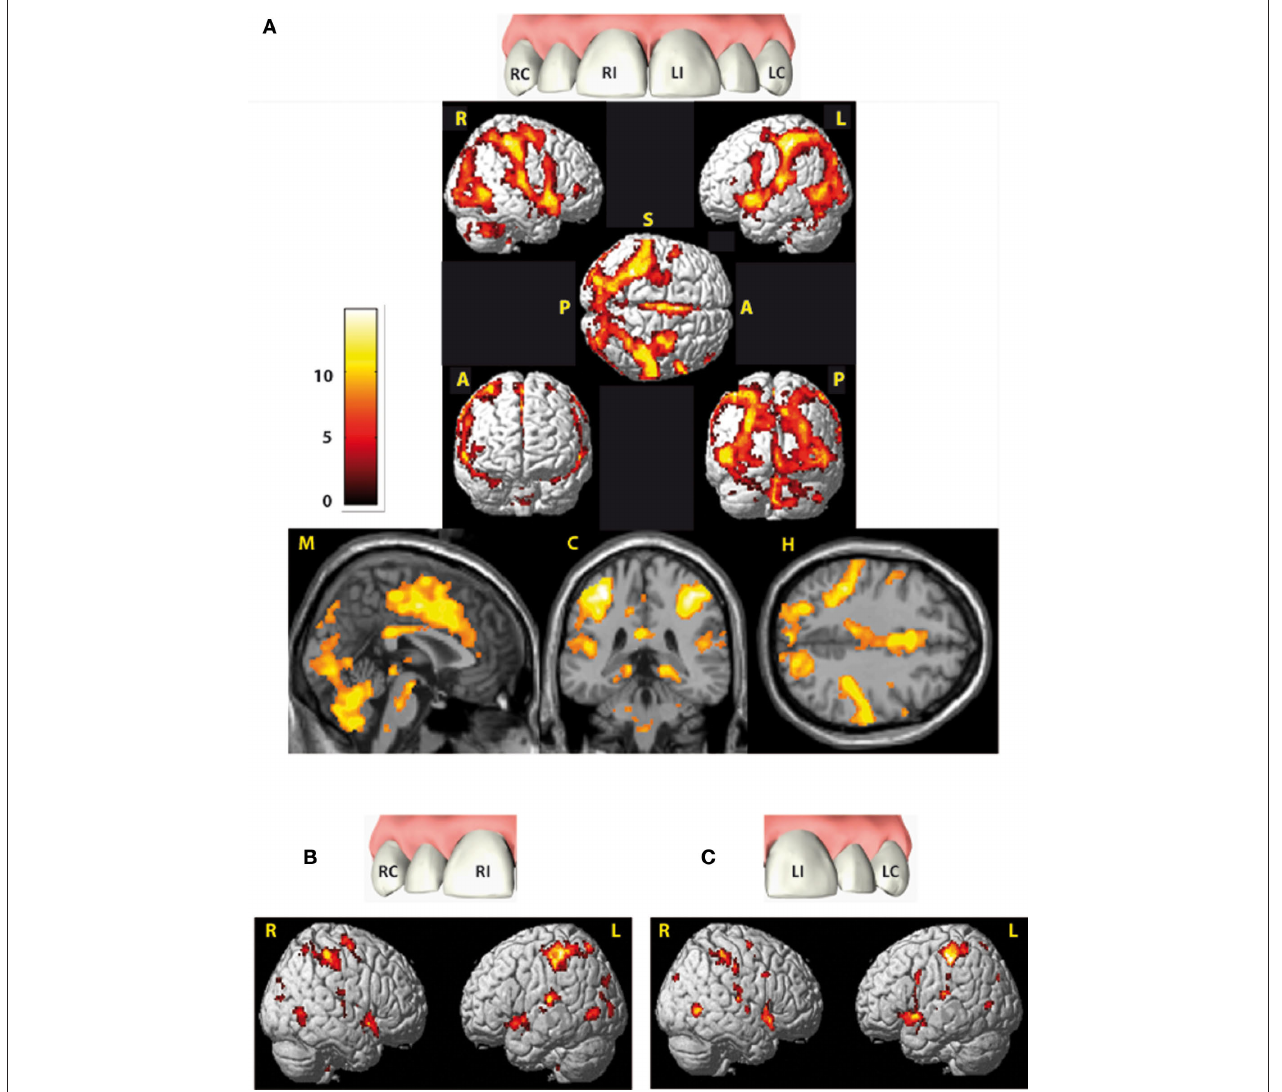
right; L, from left; S, from superior; A, from anterior; P, from posterior, all brain figures are in neurological orientation. Slices from left to right: midsagittal (M), coronal (C) at Y = − 36 and horizontal (H) at Z = 54. Data are corrected for multiple comparison (FWE) p = 0.01 with an extended threshold of 10